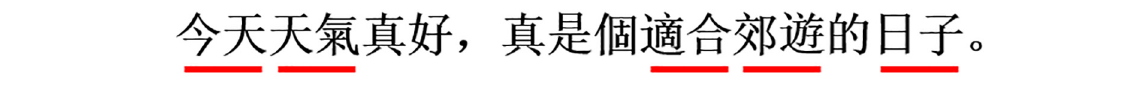
FIGURE 1 | An example of a written Chinese sentence. Words in the sentence were marked with red underlines, which would not be presented in the real reading.